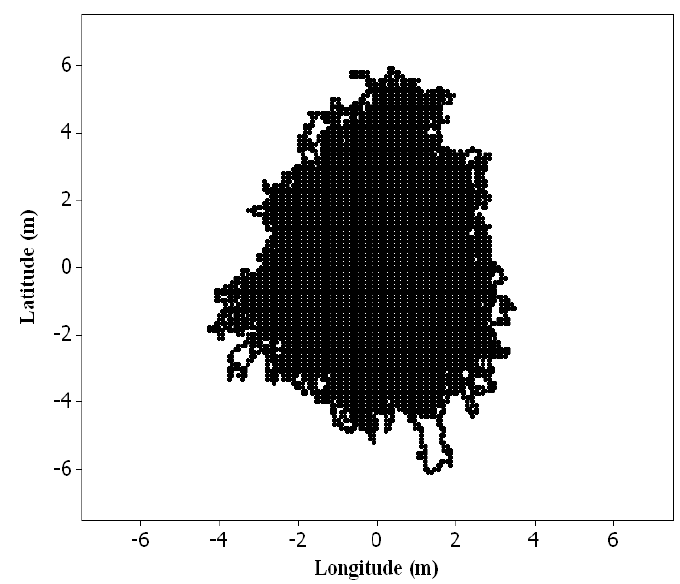
Figure 5. Positional uncertainties in DGPS